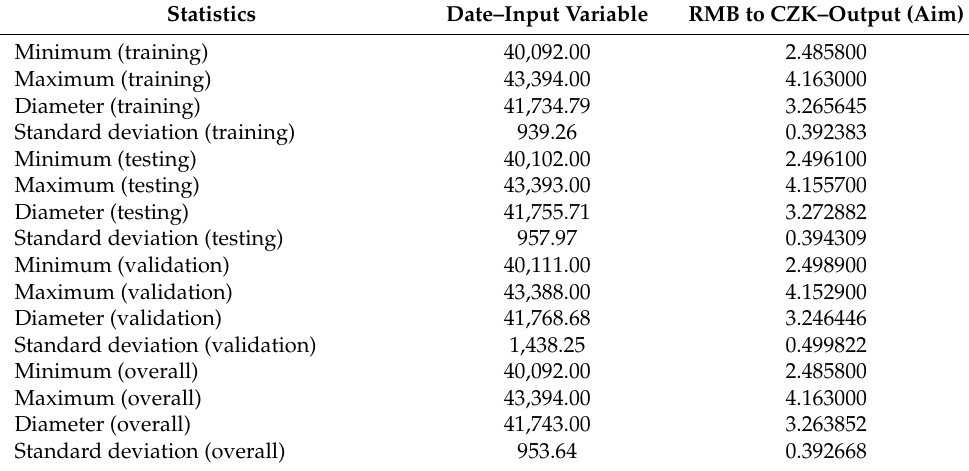
Table 1. Characteristics of the